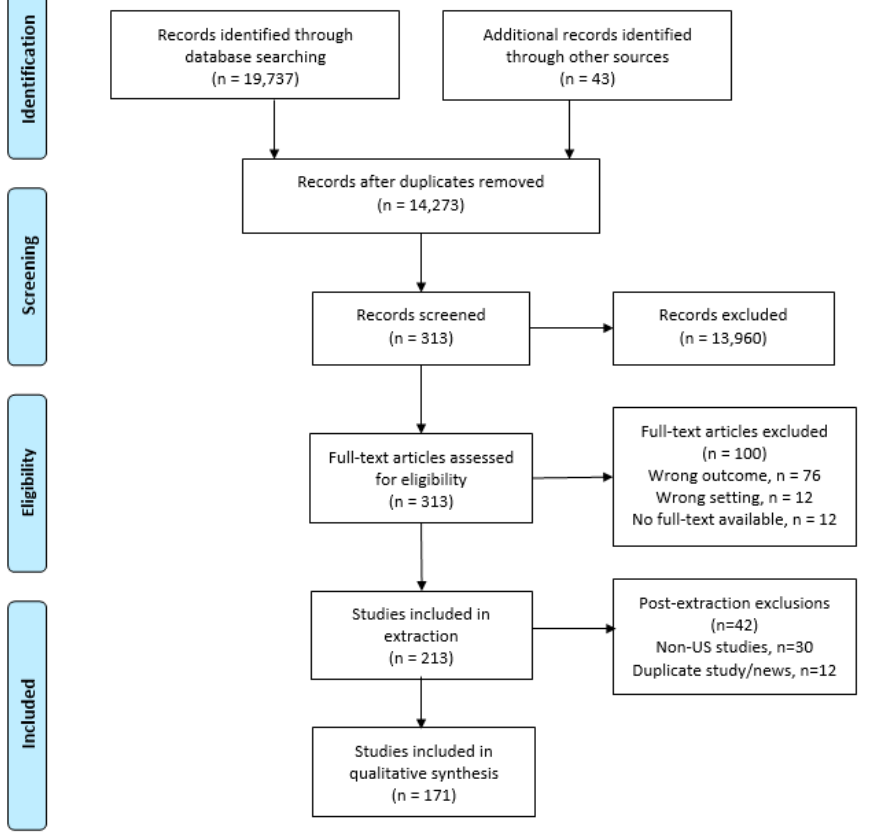
Figure 1. Flowchart for scoping review.